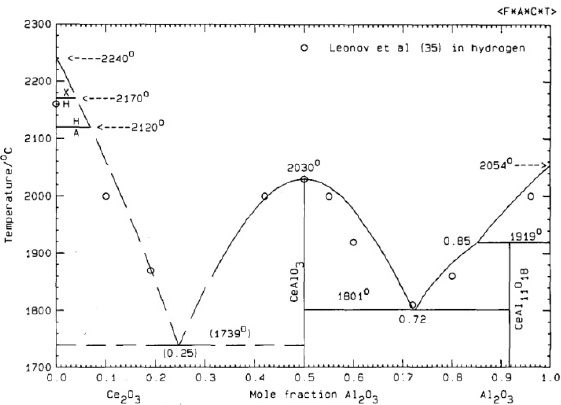
Figure 16. Pseudo-binary phase diagram of aluminum oxide and cerium oxide [26]. Reprinted from Journal of Alloys and Compounds, Vol 179, P. Wu and A.D. Pelton, “Coupled thermodynamic-phase diagram assessment of the rare earth oxide-aluminium oxide binary systems”, pages 264, Copyright (1992), with permission from Elsevier.